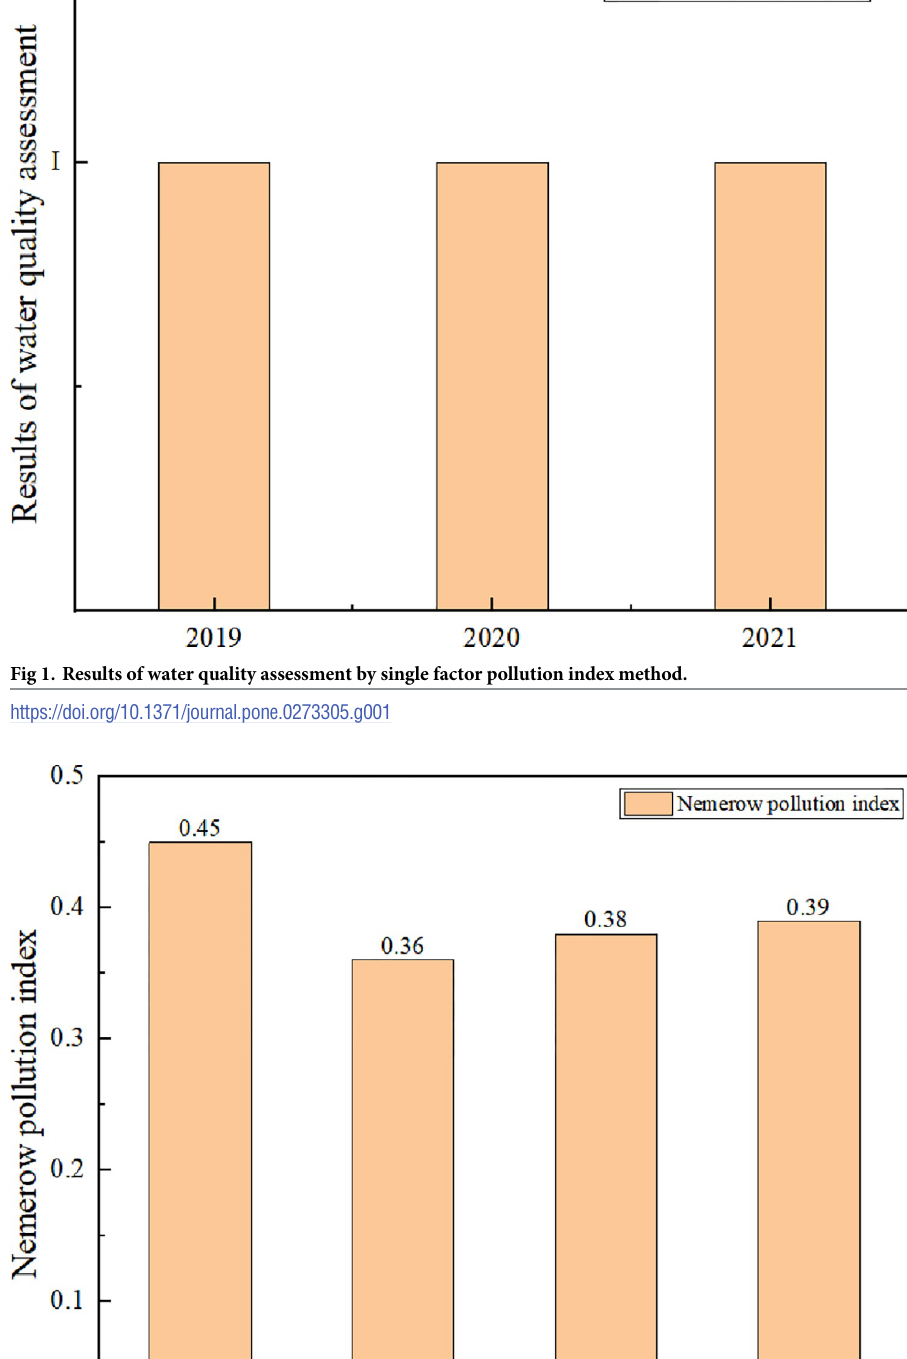
PLOS ONE | https://doi.org/10.1371/journal.pone.0273305 August 18,